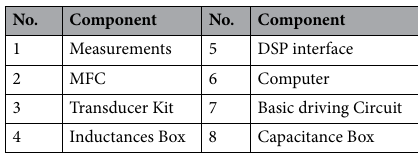
Table 5. Experimental components.